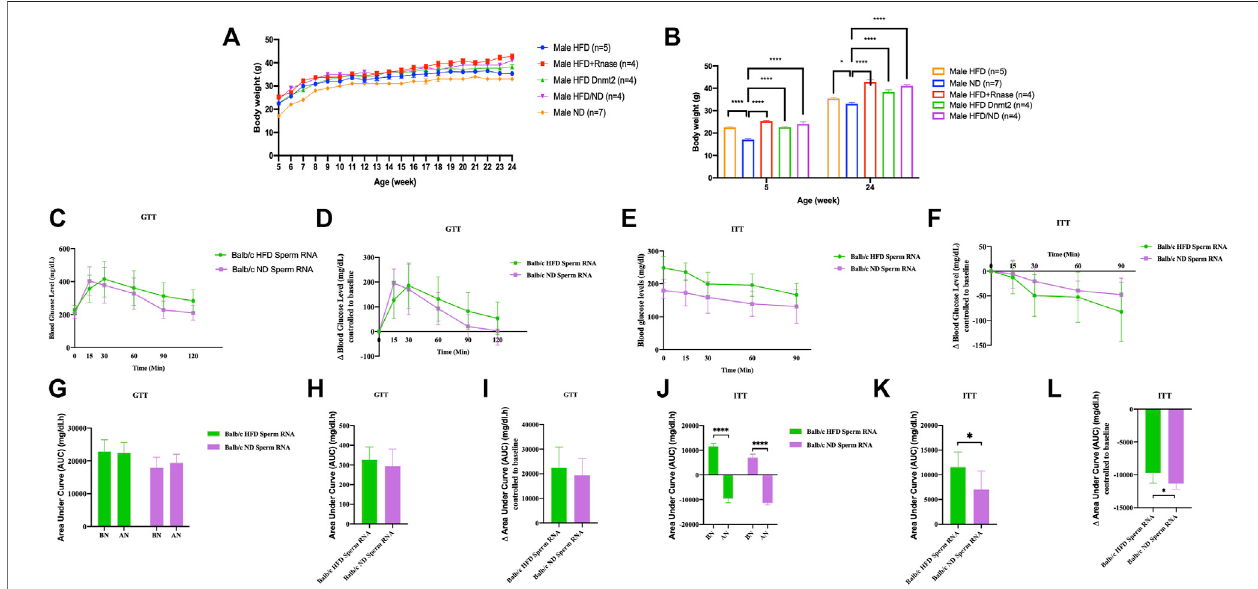
FIGURE 2 | Microinjection of total RNA of sperm from HFD-resistant males perturbs the health of susceptible offspring (Balb/c). Total sperm RNAs prepared from males raised on ND or HFD were microinjected into Balb/c fertilized eggs, as described in the Methods section. Microinjection performed with total sperm RNAs for the three lines, Balb/c, ND, HFD, Mixed ND/HFD and HFD RNA added RNase before microinjection and fi nally HFD Dnmt2-/-C57BL/6 RNA. n = number of mice in each group.AllmicewereraisedonanND.Bodyweights (A,B) ,fastingbloodglucose(GTT) (C) andinsulintolerance(ITT) (D) at15 weeksarepresented formales. The area under curve (AUC)30 after normalization werealso calculated based on theglucose levels ofeach time point (E, F) (Each group vscontrolND). Females areshown in Supplementary Figure S13 . Comparison with or without normalization of GTT (G – I) and ITT (J – L) challenges analysis. Statistical analysis was performed by two- tailed, one-wayanalysisofvariance (ANOVA), uncorrectedFisher ’ sleast signi fi cantdifference (LSD).* p < 0.05,** p < 0.01, *** p < 0.001****p < 0.0001(ND versuseach group).Ns,notsigni fi cant.Alldataareplottedasmean±s.e.m. Allrawdataarepresented in SupplementaryTableS2 andindividualrawdatainSupplementaryTable for Figure 2